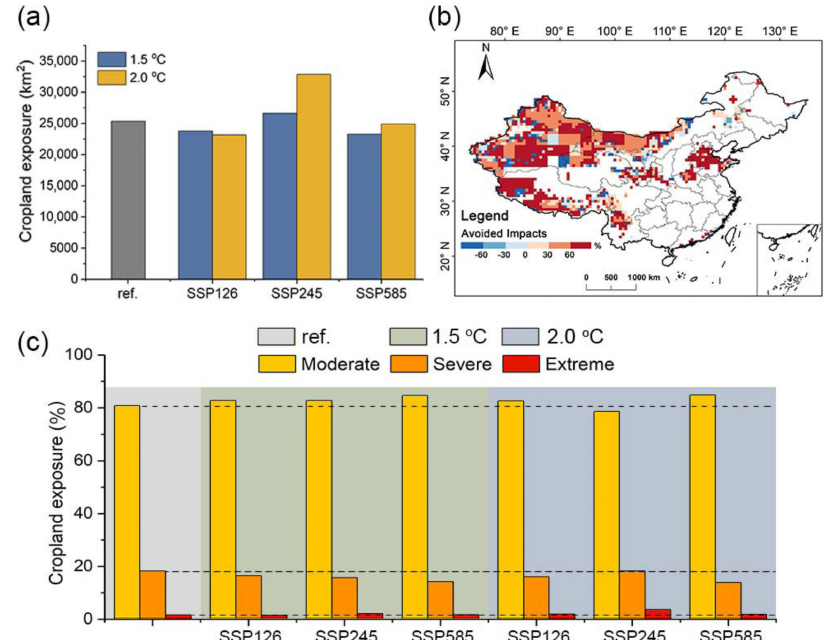
Figure 7. ( a ) Cropland exposure to droughts in reference period and the 1.5/2.0 ◦ C global warming periods, unit: km 2 ; ( b ) Spatial distributions of the avoided impacts (the potential reduction in the cropland exposure to droughts) in China due to 0.5 ◦ C less warming (limiting the global warming to 1.5 ◦ C instead of 2.0 ◦ C), unit: %; ( c ) Cropland exposure to moderate, severe, and extreme droughts in China in reference period and the 1.5/2.0 ◦ C global warming periods, unit: